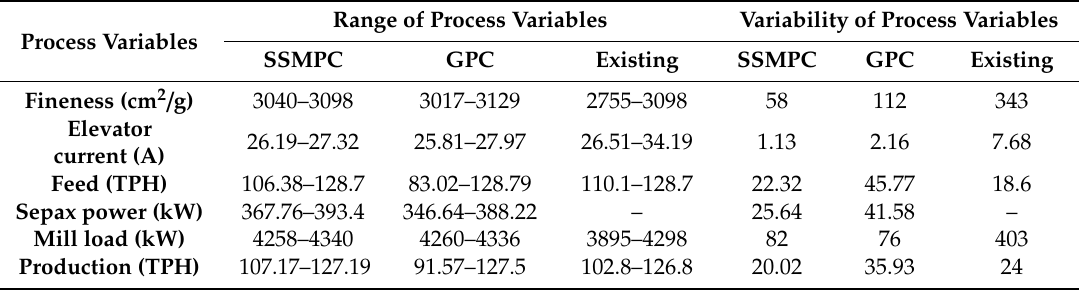
Table 4. Variability and range of process variables when di ff erent controllers are implemented under closed-loop conditions.